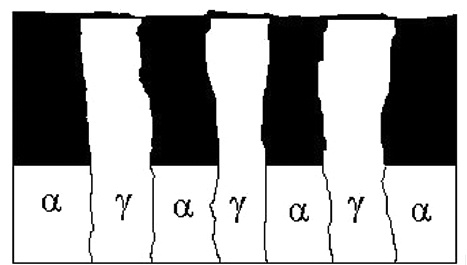
Figure 6. Theorical morphology of the nitrided layer. Only is considered bulk nitrogen diffusion.